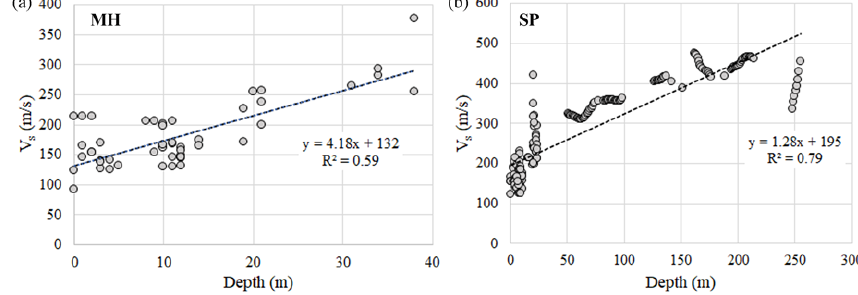
Figure 6. Scatter plot and regression line model for lithology MH (a) and SP (b) . Equations and R 2 are also